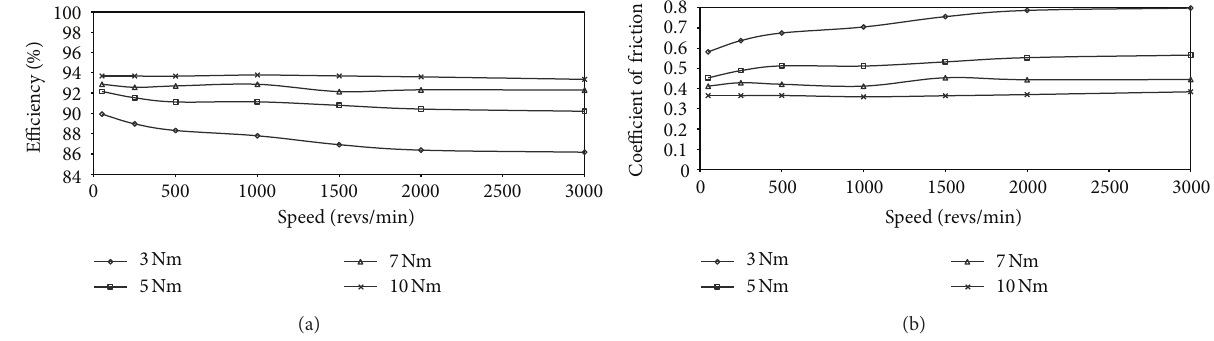
F 9: Showing (a) the efficiency and (b) the derived coefficients of friction for 20